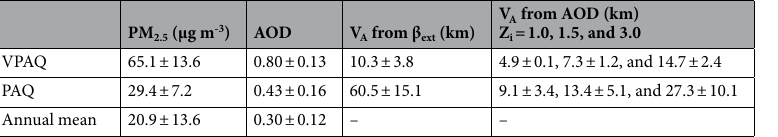
Table 1. Average values of PM 2.5 concentration (ICACC measurements), AOD, and V a during VPAQ days (May 10–17), PAQ (May 01–09 and 18–31), and annual means.